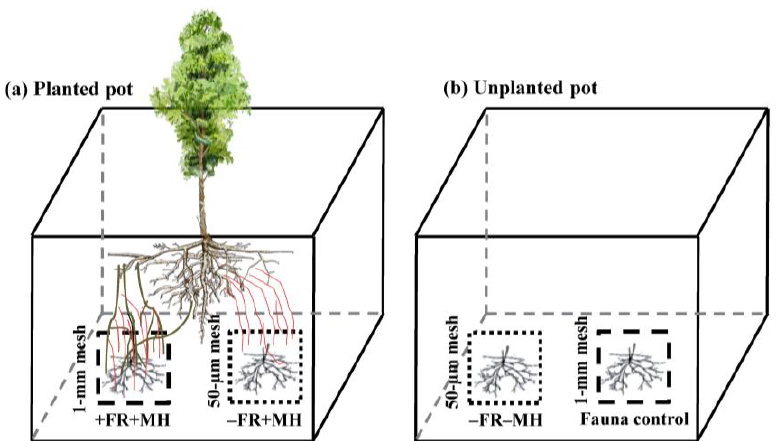
Figure 1. Schematic diagram of the pot experiment design. For a given tree species, there were a planted pot ( a ) and an unplanted pot ( b ) per block and each pot contained two litterbags of di ff erent mesh sizes (50- µ m and 1-mm) filled with root litter of this species. In panel ( a ), brown and red lines in litterbags represent fine roots (FR) and mycorrhizal hyphae (MH), respectively. 151 Rectangular pots (25 cm length × 15 cm width × 20 cm height) were used to examine the effects 152